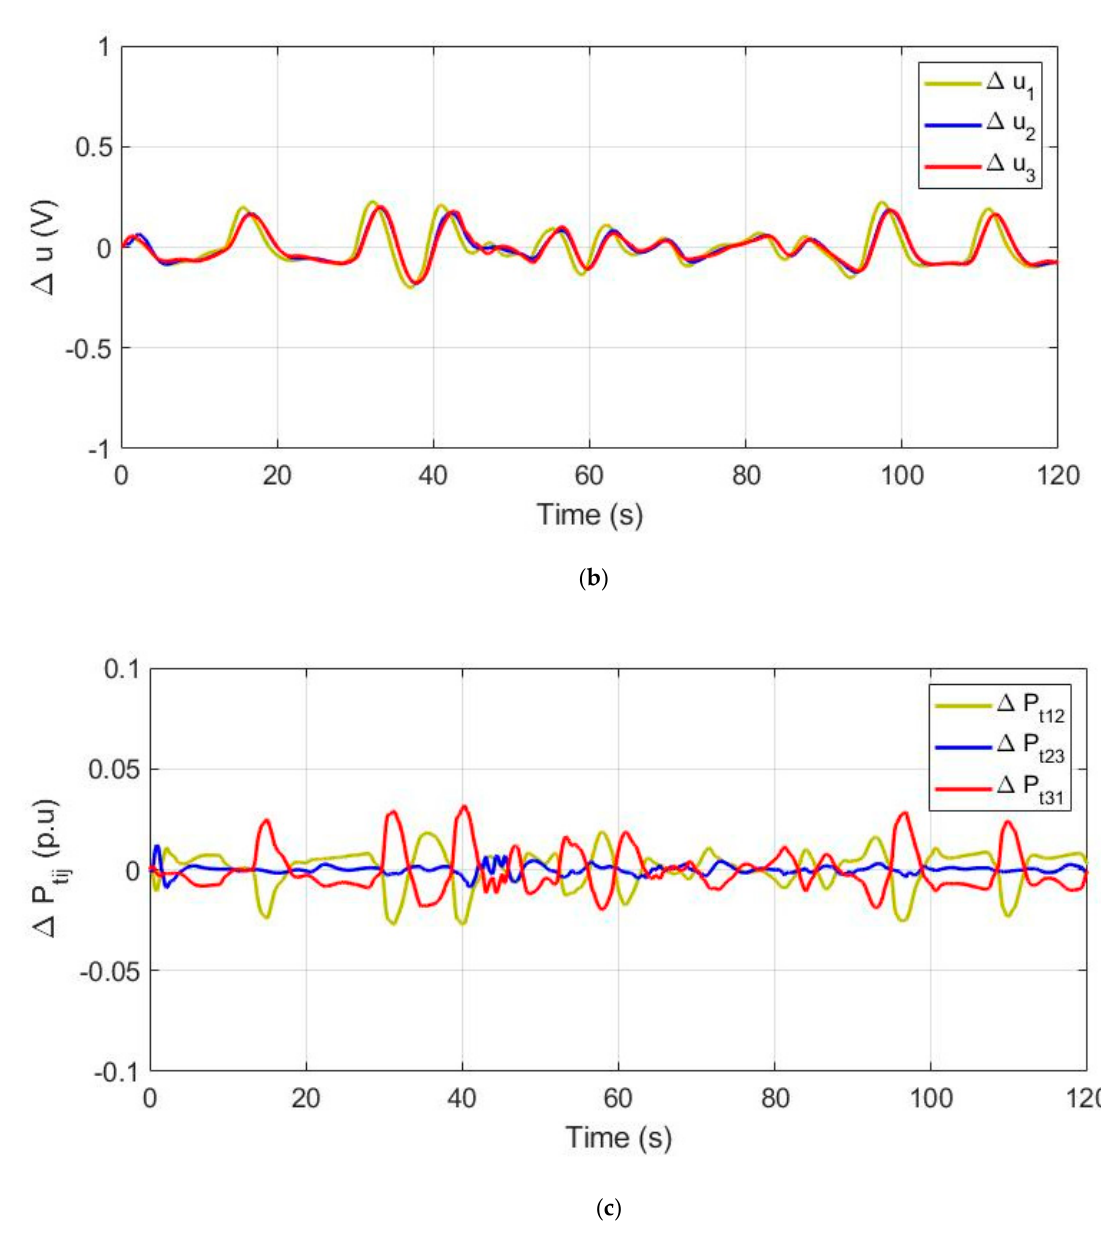
Figure 12. Case 4: ( a ) frequencies ( ∆ f i ), ( b ) voltages ( ∆ u i ), and ( c ) ∆ P tij responses. Case 5: Responses of Distributed Microgrids in Normal Climate with